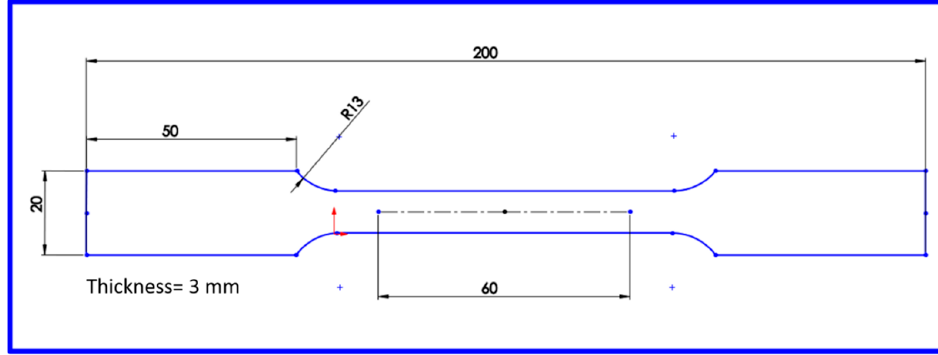
Figure 4. Dimensions of the tensile specimens according to ASTM E64-00 standard (mm).